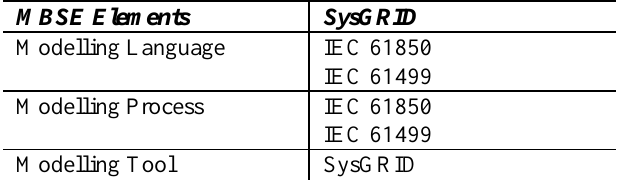
Table 1. Elements of SysGRID in